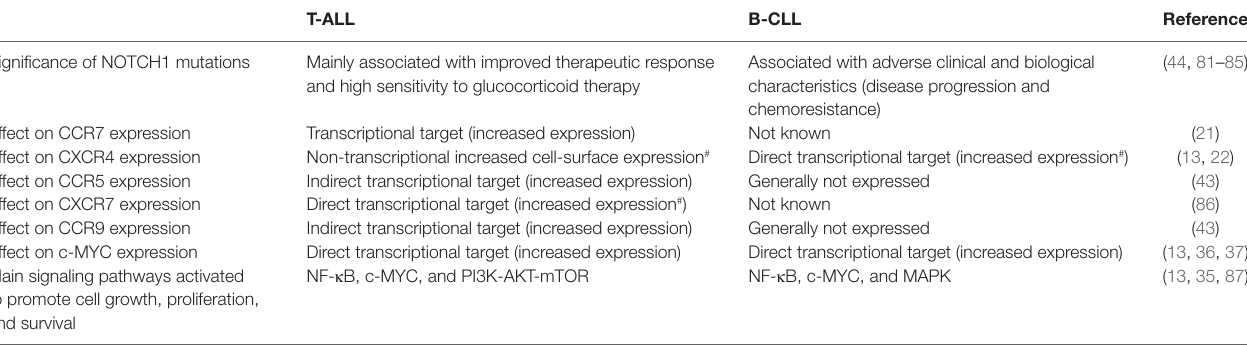
TABLe 1 | Functional similarities and differences determined by NOTCH1 in influencing the biological behavior of T-cell acute lymphoblastic leukemia (T-ALL) and B-cell chronic lymphocytic leukemia (B-CLL) cells. T-ALL B-CLL